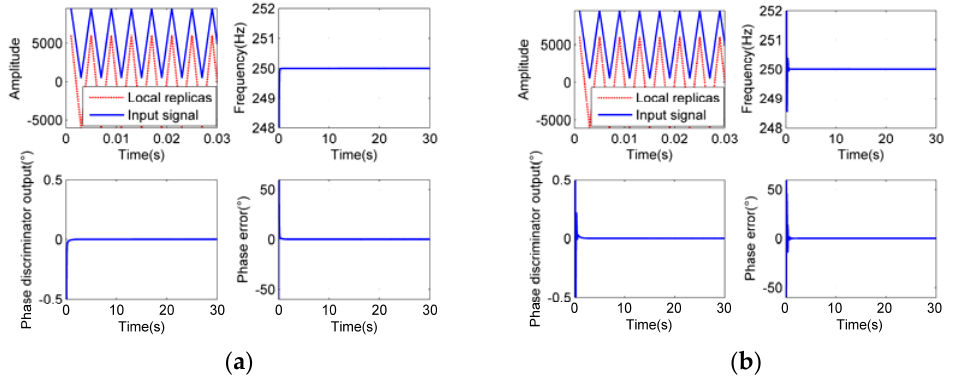
Figure 16. Tracking process at rotational speed of 250 Hz, B FLL = 0.5 Hz, B PLL = 1.0 Hz, ξ = 0.5. ( a ) is the tracking result at T roll = 20 ms, ( b ) is at T roll = 50 ms.